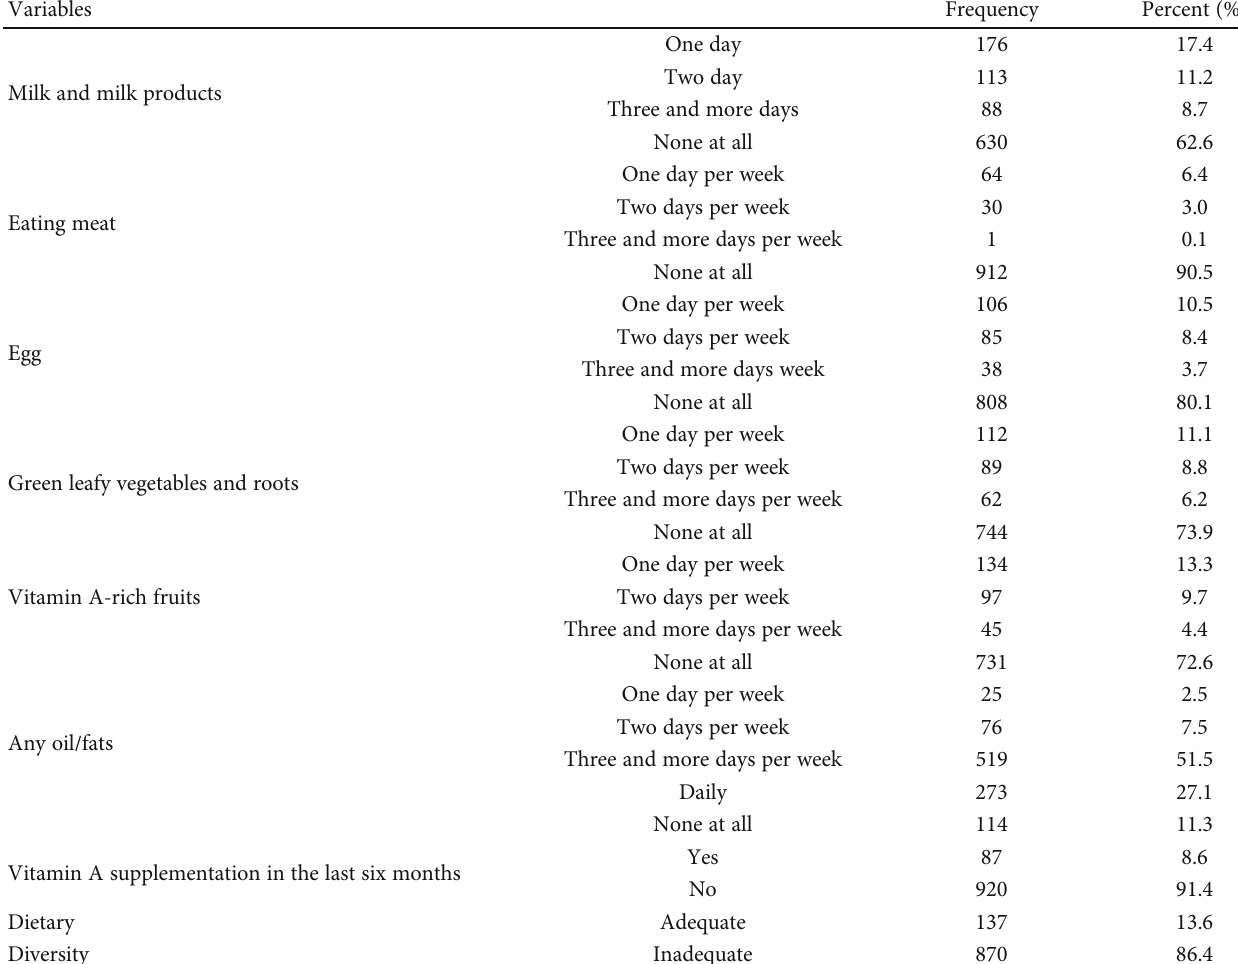
Table 4: Dietary characteristics among children aged 24-59 months in Lay Armachiho District, Central Gondar Zone, northwest Ethiopia, 2019.